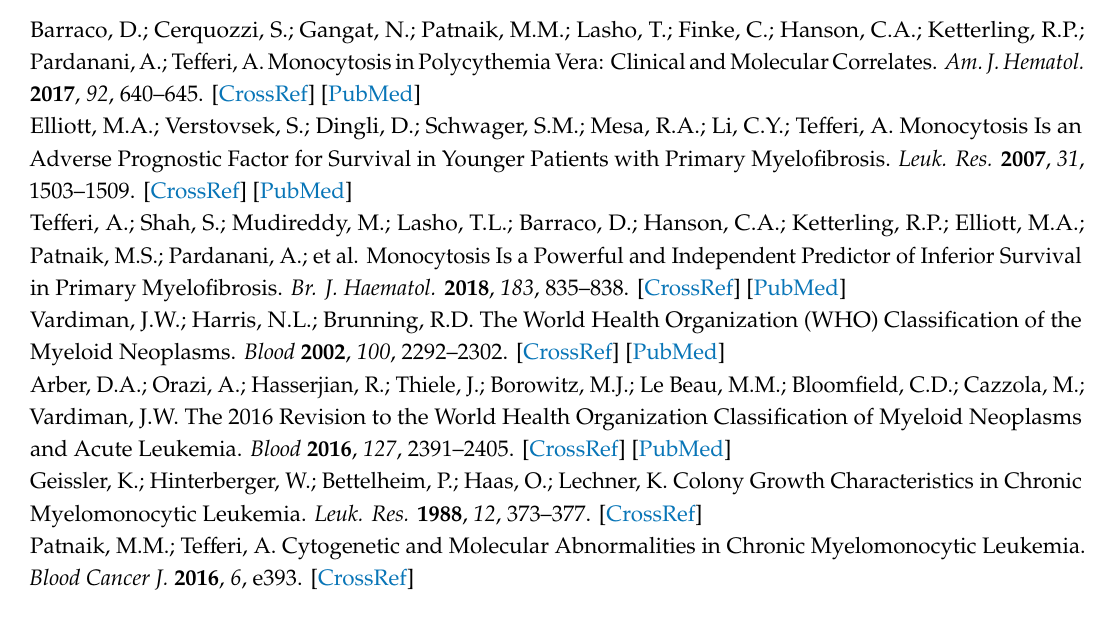
Table S1: Features of 41 patients with myeloproliferative neoplasms developing a chronic myelomonocytic leukemia-like phenotype, Table S2: Variants of additional mutations in patients with MPN / CMML and JAK2 -mutated